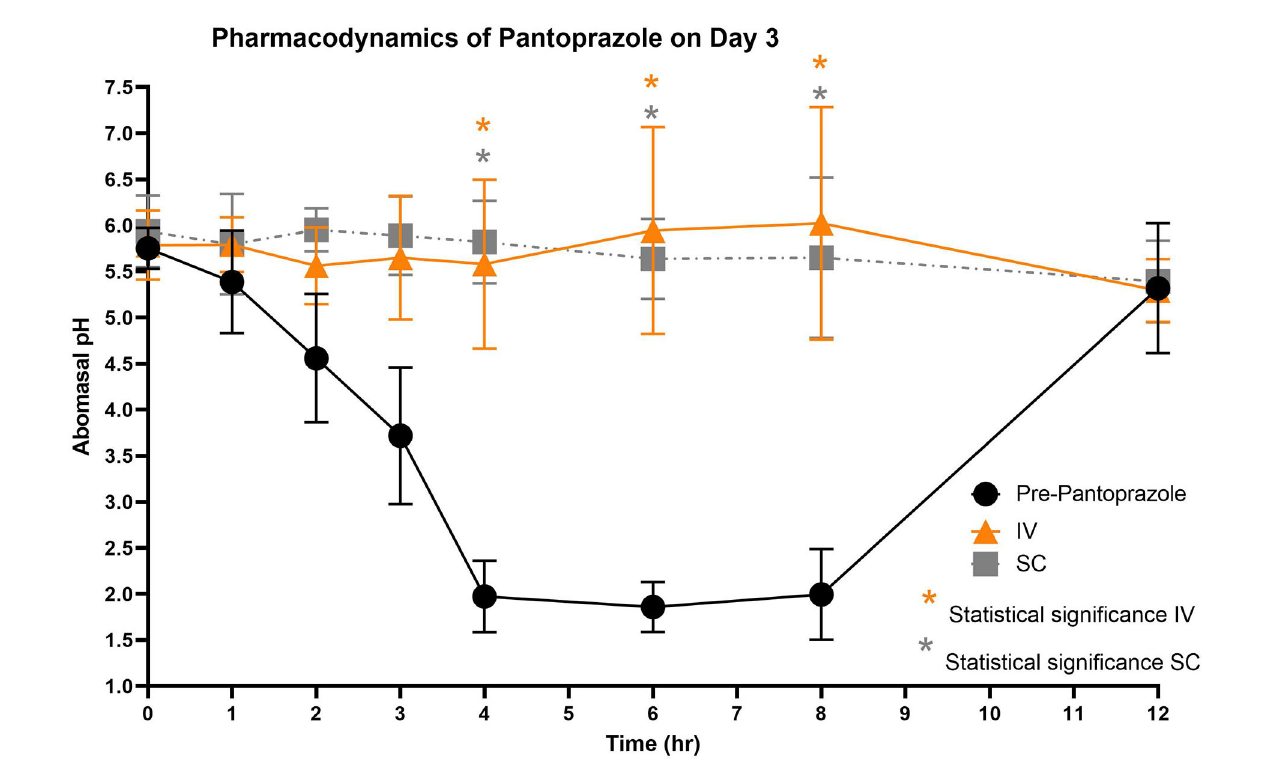
FIGURE5 Comparison of abomasal pH over time between control, IV, and SC treatment groups on Day 3. Black circles, pH pre-pantoprazole administration; Orange triangles, pH after IV pantoprazole administration; Gray square, pH after SC administration. Statistical significance ( P < 0.05) noted with asterisk.